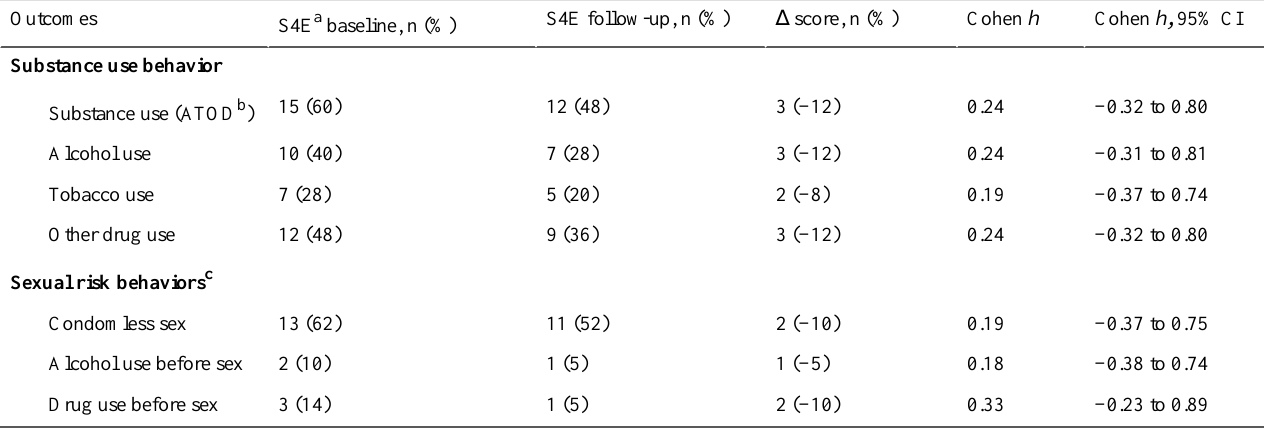
Table 5. Past 30-day Storytelling 4 Empowerment intervention effects on behaviors from baseline to follow-up